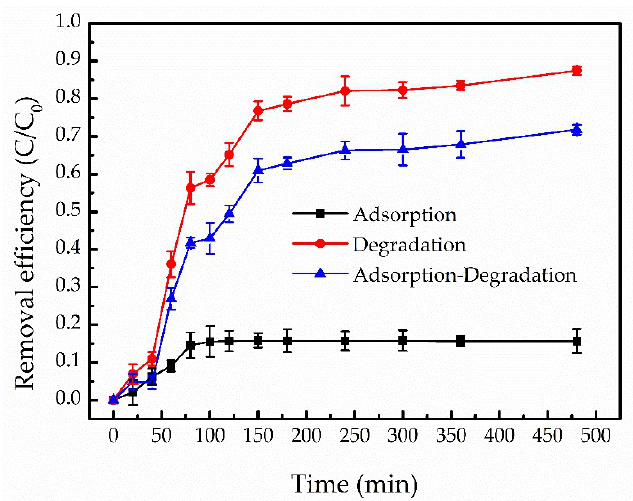
Figure 3. The contrast of adsorption and degradation. Reaction conditions: [H 2 O 2 ] 0 = 11.5 g/L, [Goethite] = 3.33 g/L, pH = 4, T = 293 K.